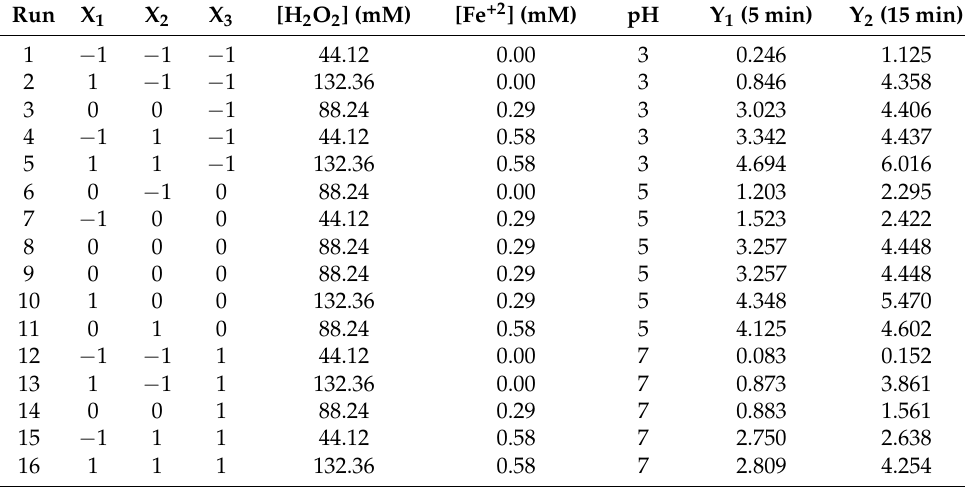
Table 3. Arrangement of CCD for the three independent variables used in FP.